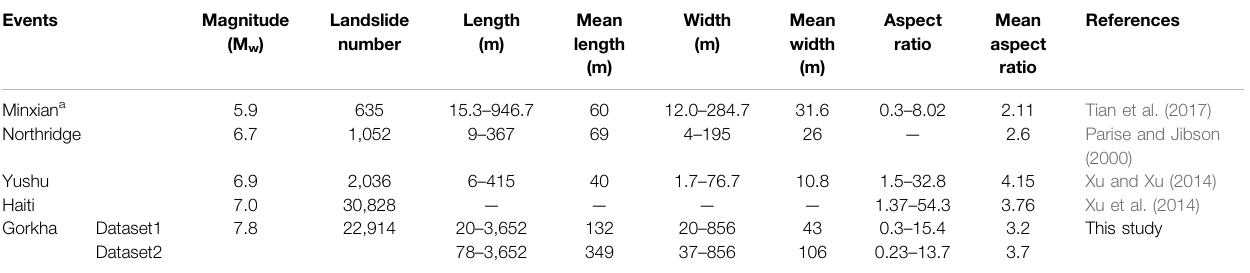
TABLE 2 | Landslide ’ s lengths, widths and aspect ratios of fi ve earthquake